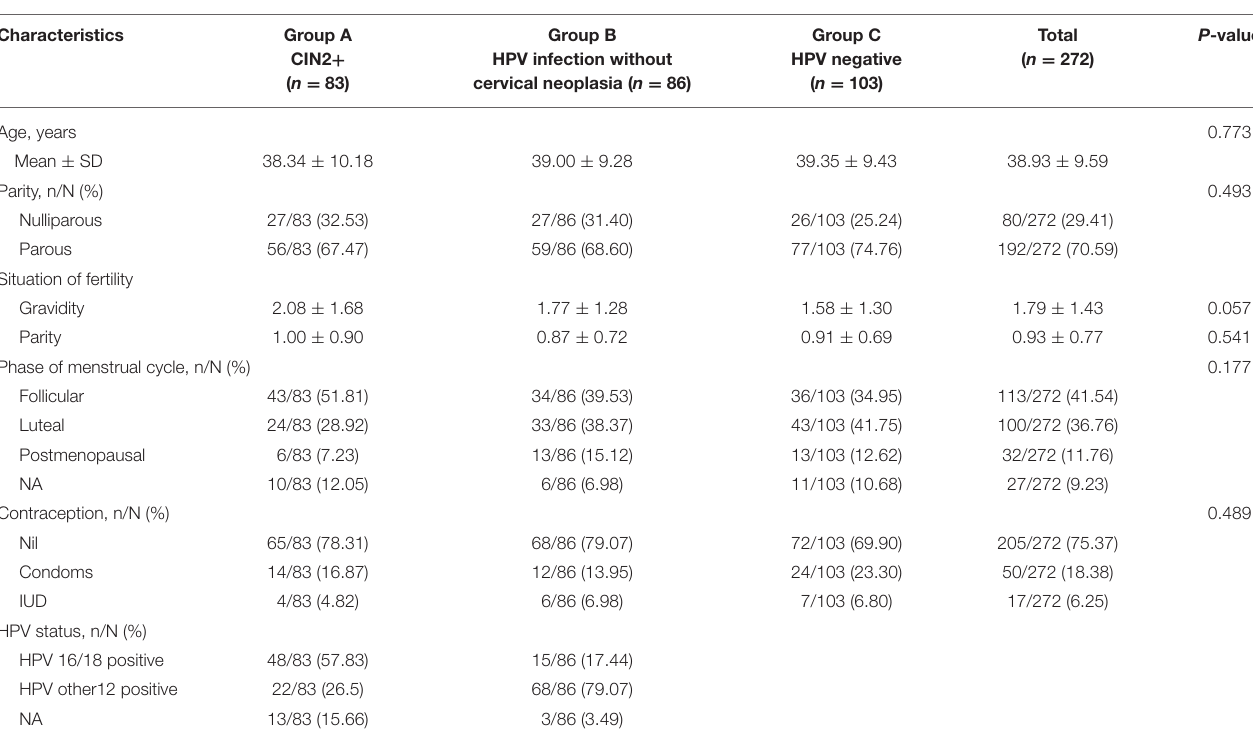
TABLE 1 | Patients’ sociodemographic and clinical baseline